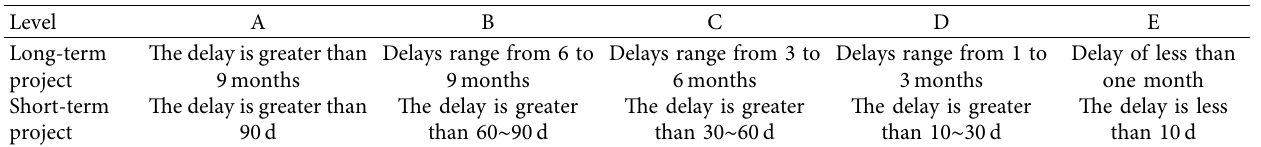
Table 7: Schedule delay grade